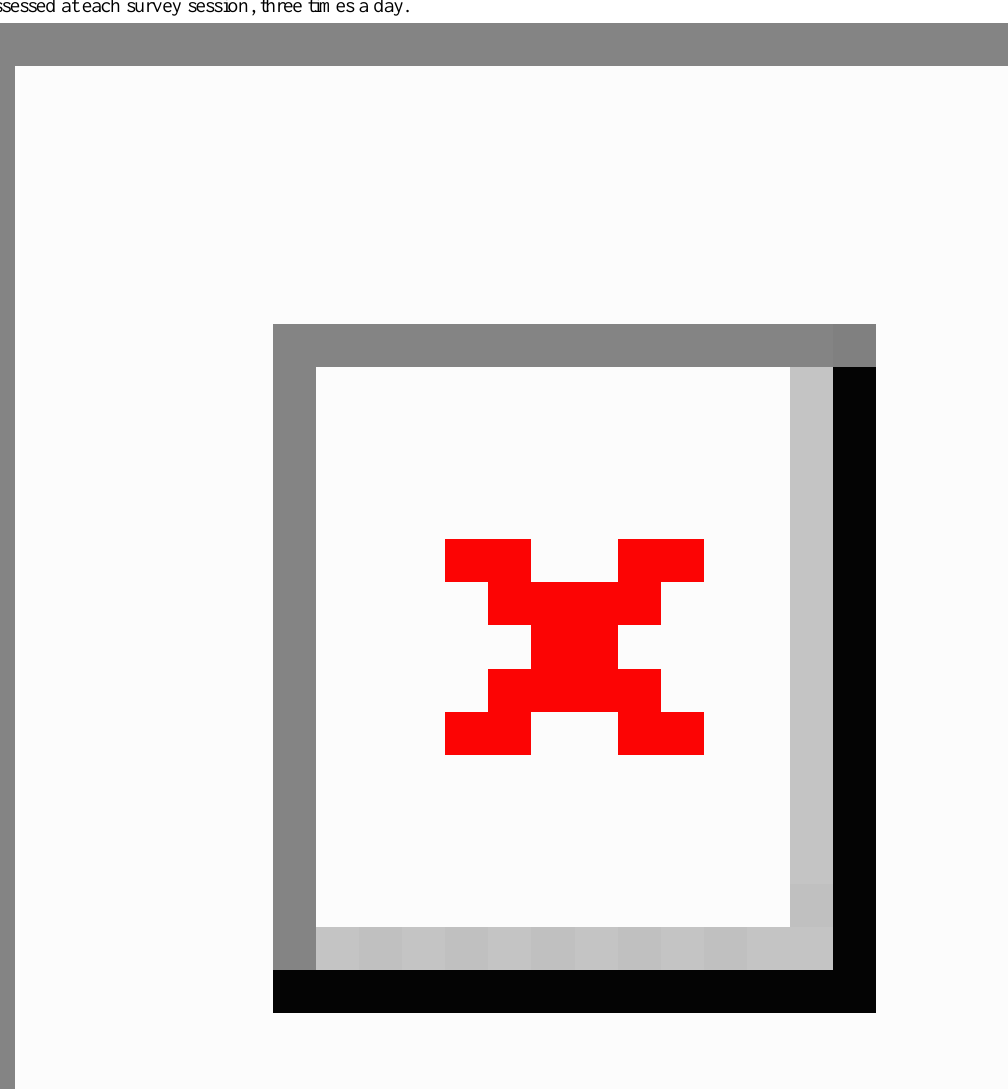
Figure 1. Screenshot of the Mindful Moods app. The app consisted only of a log-in screen and this survey screen on which randomized PHQ-9 questions were assessed at each survey session, three times a